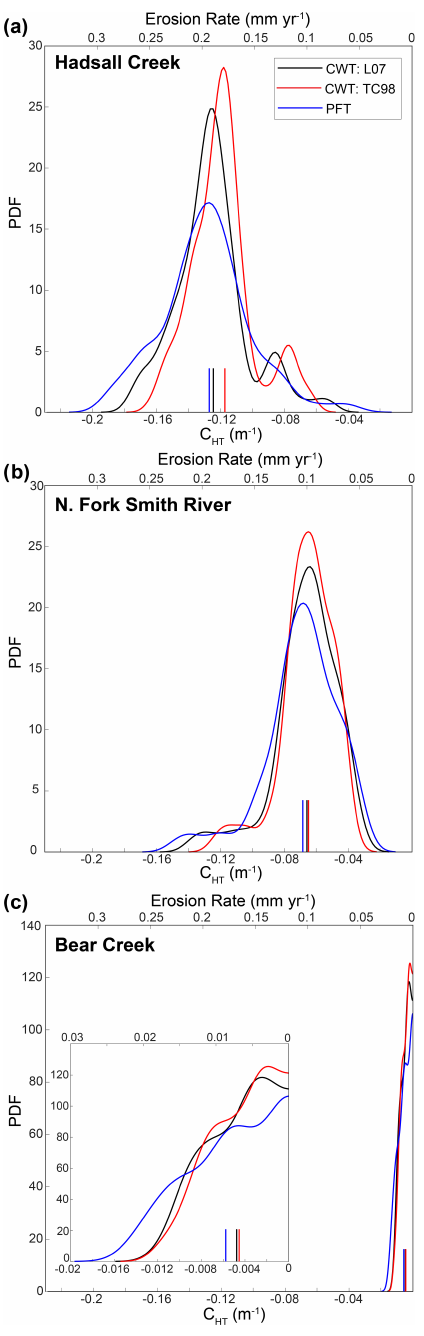
Figure 6. Probability density functions of C HT (bottom x axis) and erosion rate calculated using Eq. (1) (top x axis) for the represen- tative hilltop at each OCR field site. See Fig. S1 for all mapped hilltops version. Note the agreement between each C HT calculation method. Further, note the dramatic variability in C HT between sites (all panels use same x axis; inset in panel c more clearly displays distribution of C HT at Bear Creek). Small vertical lines at bottom of each panel represent the mean of the plotted distribution (Ta- ble 2). Note that positive C HT values are not permitted in the output PDF (c) . L07: Lashermes et al. (2007); TC98: Torrence and Compo (1998).